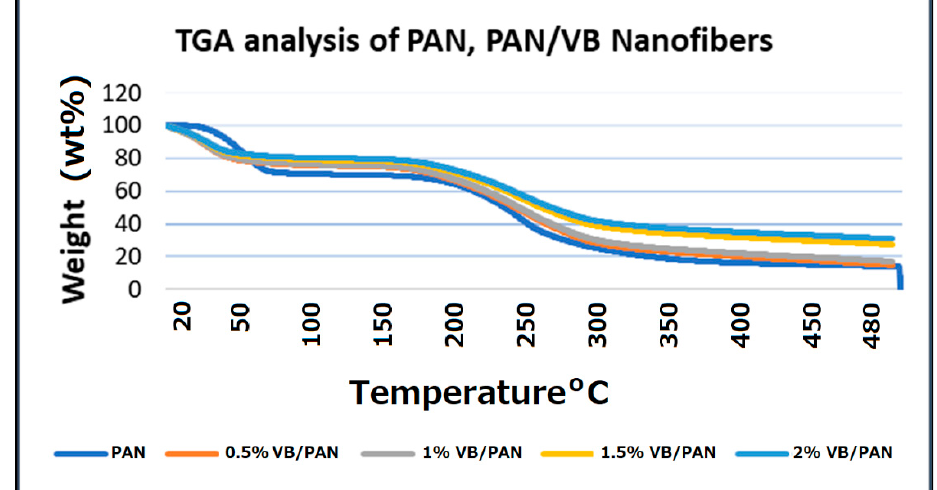
Figure 5. TGA spectra of PAN and VB/PAN nanofibers.